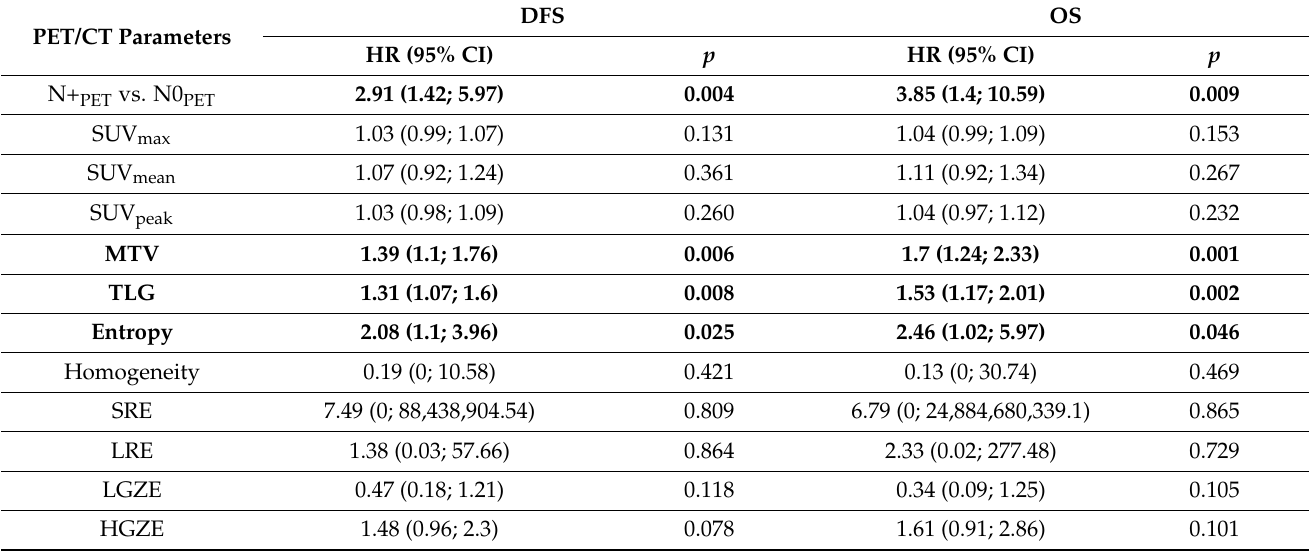
Table 5. Univariate analysis using a Cox model of PET/CT features of the primary breast tumor with DFS and OS for the 111 TNBC